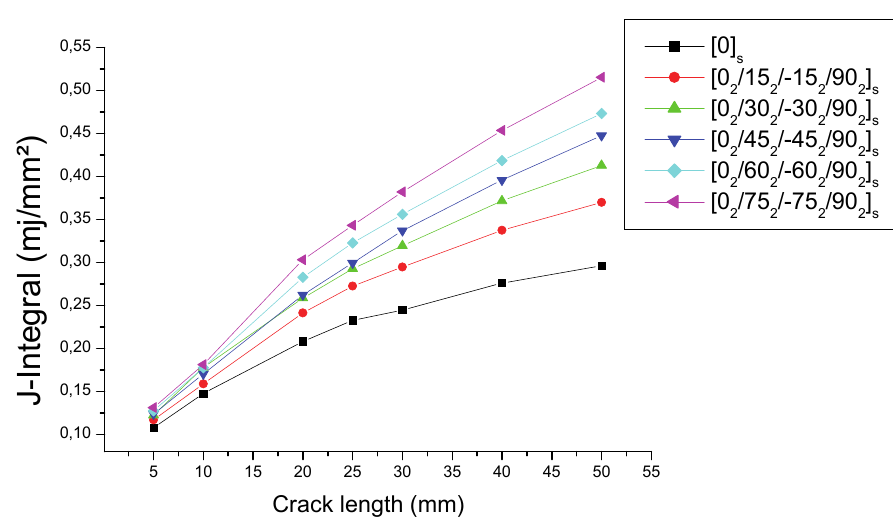
Figure 6 : Variation J-Integral in function of the length of the crack for a different sequence of stacking.